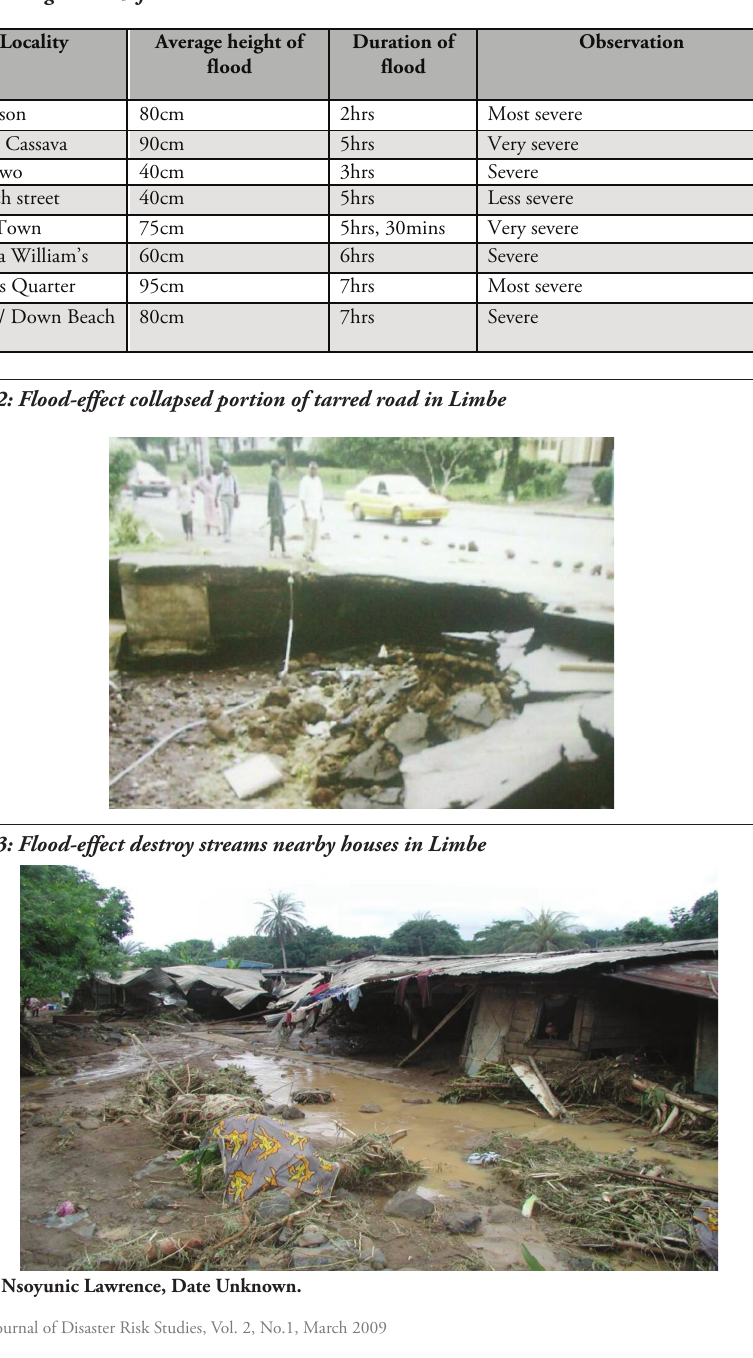
Table 3. August 2005 flood observation